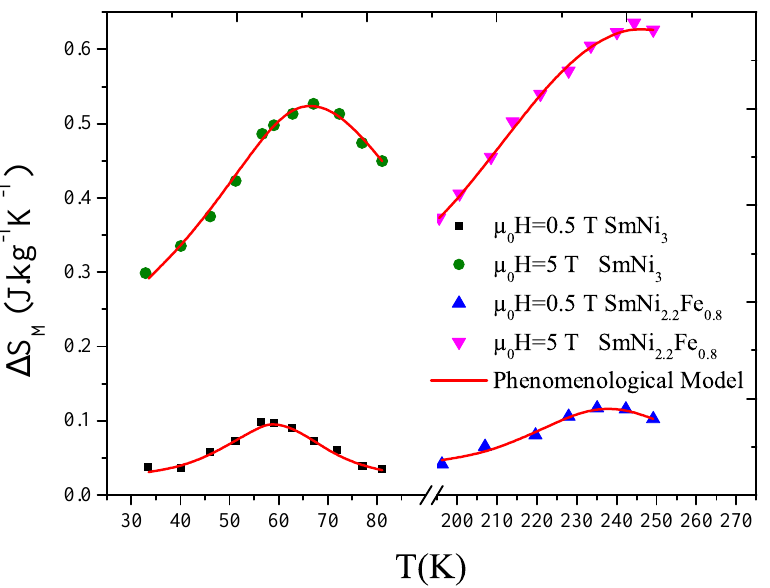
Figure 14. Comparison between theoretical and experimental magnetic entropy change plotted against temperature for SmNi 2.2 Fe 0.8 and SmNi 3 under 0.5 and